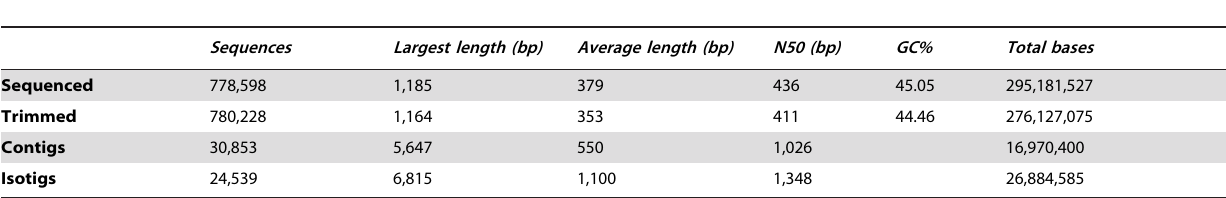
Table 2. Summary and de novo assembly of I. ricinus salivary gland transcriptome sequenced by 454 Pyrosequencing.